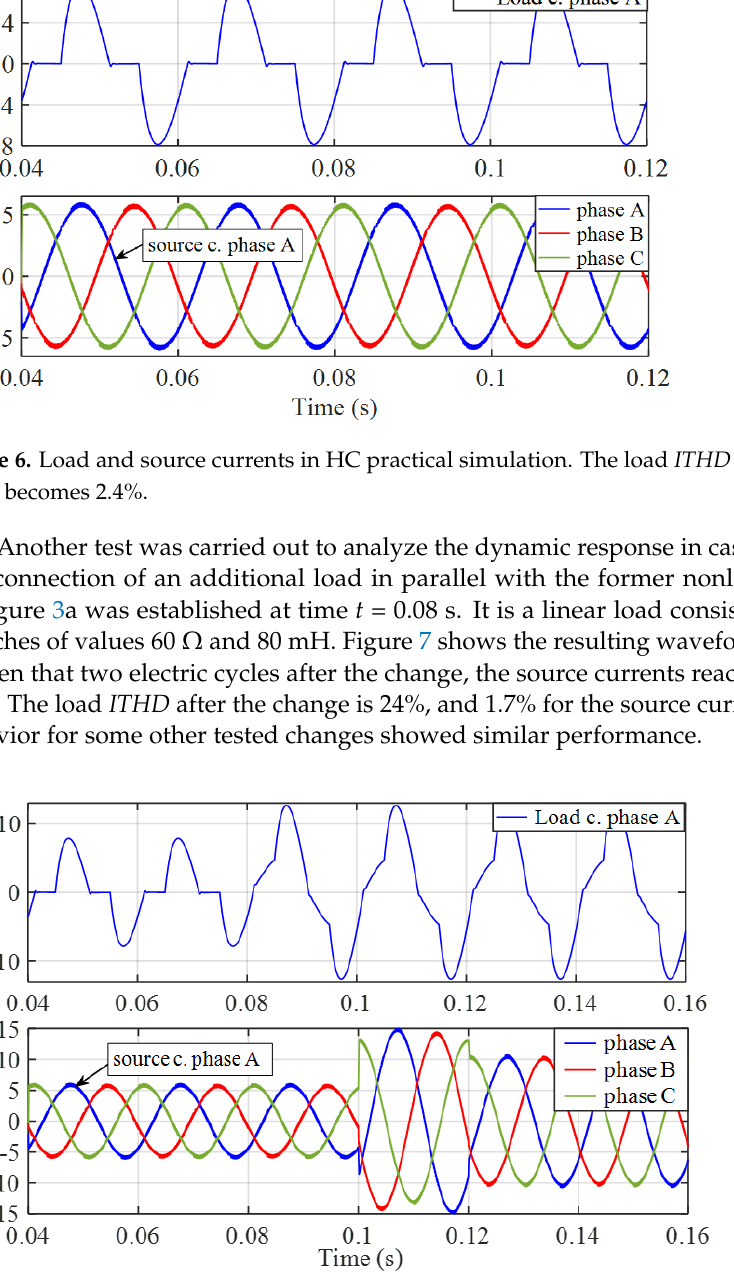
Figure 7. Dynamic performance of HC case, linear load addition at t = 0.08 s. Up: load current. Down: source currents. ITHD become 1.7%.